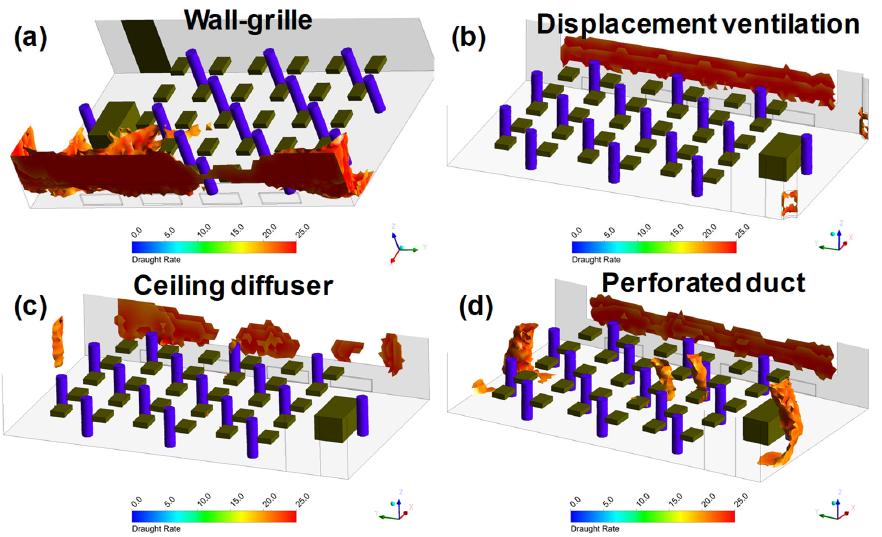
Figure 15. Draft rate of more than 20% in winter conditions.